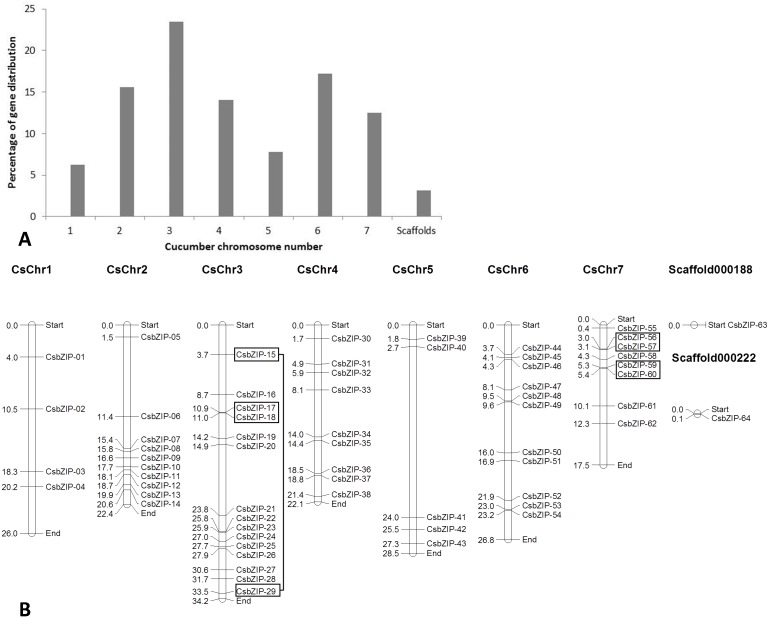
Distribution of 64 CsbZIP genes onto seven cucumber chromosomes.(A) Percentage of bZIP genes on each cucumber chromosome to show their distribution abundance. (B) Graphical (scaled) representation of physical locations for each CsbZIP gene on cucumber chromosomes (numbered 1–7). Tandem-duplicated genes on a particular chromosome are indicated in the box. Chromosomal distances are given in Mbp.